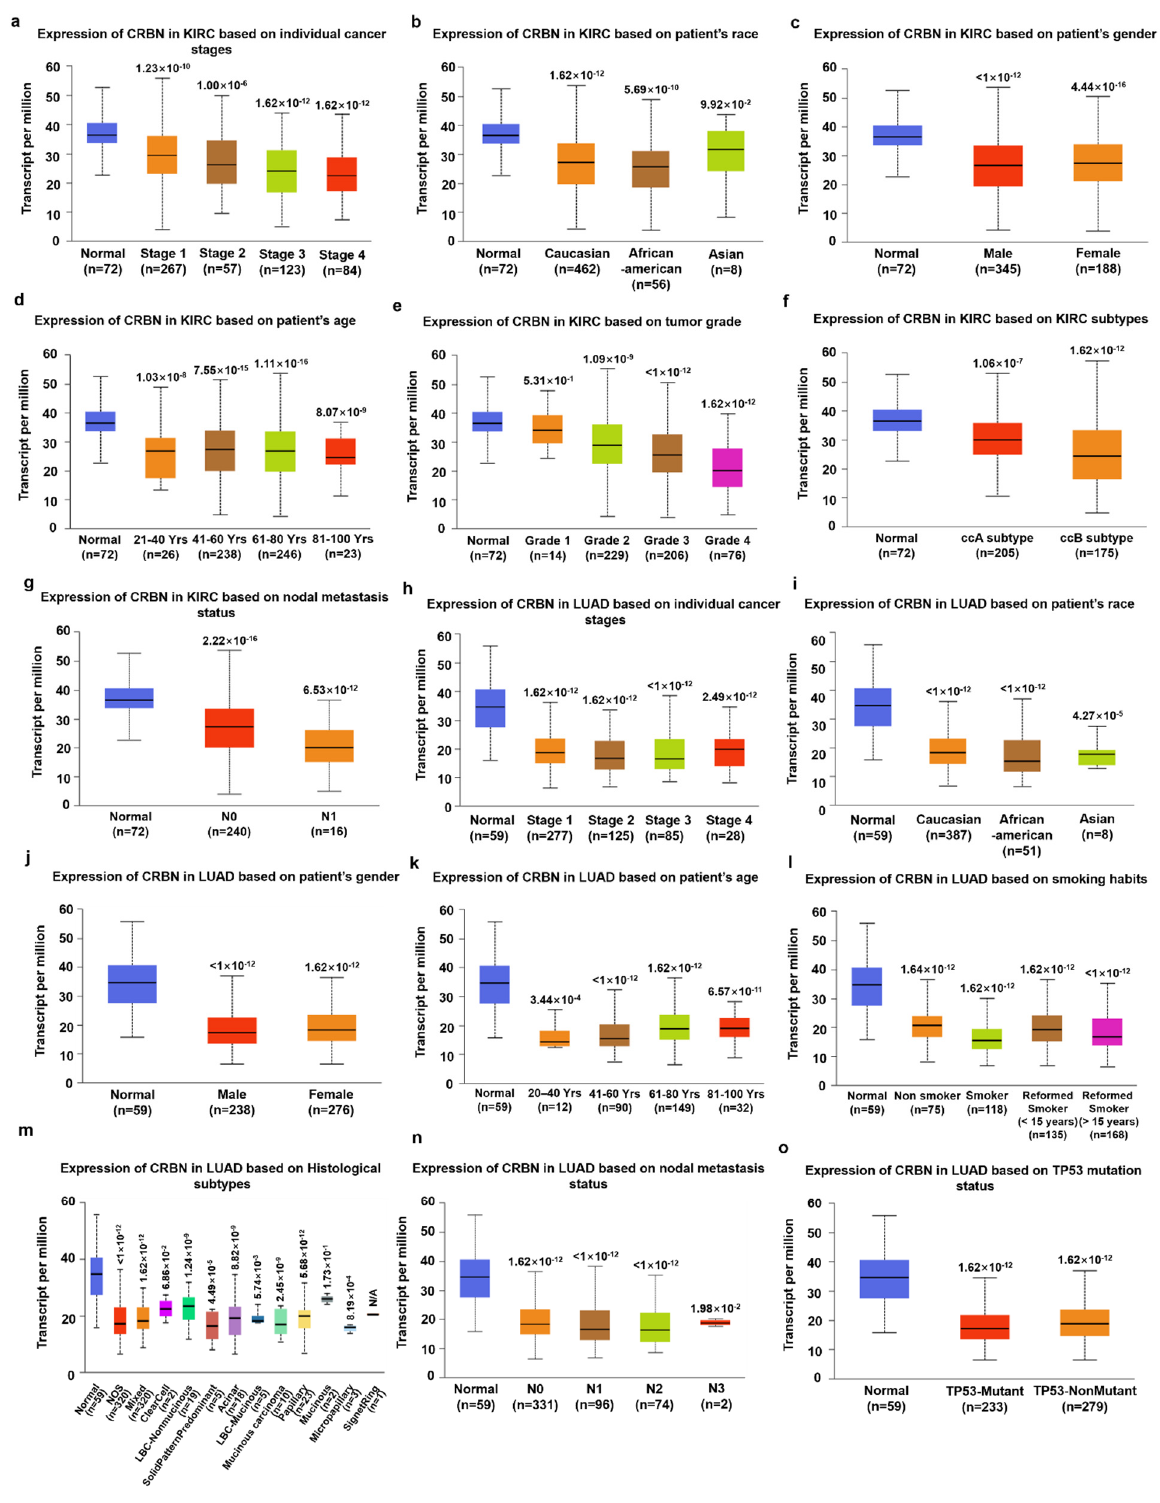
Figure 3. Differences in CRBN expression according to the clinicopathological factors of KIRC and LUAD patients. The expression levels of CRBN according to each clinicopathological characteristic were visualized with boxplots using the UALCAN web tool to explore the TCGA dataset (http://ualcan.path.uab.edu/index.html, accessed on 23 August 2020). Specifically, the mRNA expression of CRBN in KIRC was plotted against ( a ) individual cancer stages, ( b ) patient race, ( c ) patient gender, ( d ) patient age, ( e ) tumor grade, ( f ) KIRC subtypes, and ( g ) nodal metastasis status. Similarly, LUAD expression was plotted against ( h ) individual cancer stages, ( i ) patient race, ( j ) patient gender, ( k ) patient age, ( l ) smoking habits, ( m ) histological subtypes, ( n ) nodal metastasis status, and ( o ) TP53 mutation status.